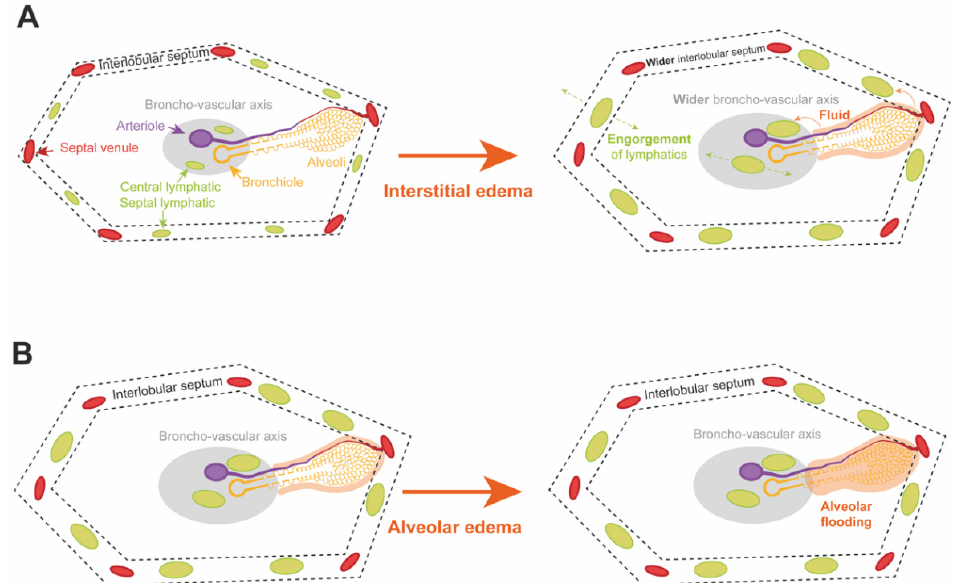
Figure 3. Development of interstitial and alveolar edema in the secondary pulmonary lobule. ( A ) Interstitial edema after LTx is marked by an increase of interstitial fluid that is cleared by the central and septal lymphatic channels that become engorged. The widened aspect of the interlobular sep- tum and broncho-vascular axis explain the reticular pattern observed in chest computed tomogra- phy (CT) and clarifies the macroscopic aspect of the interlobular septa that become visibly dis- tended. ( B ) In high-grade PGD after lung transplantation, the stage of interstitial edema progresses to the stage of alveolar edema. The alveolo-capillary membrane permeability and intracapillary hy- drostatic pressure continue to increase while alveolar, lymphatic and venous fluid clearance be- comes saturated. Flooding of the interstitial and alveolar space explains the ground glass opacities (GGOs) observed on chest CT and represents the edematous and glassy macroscopical aspect of the secondary pulmonary lobules.